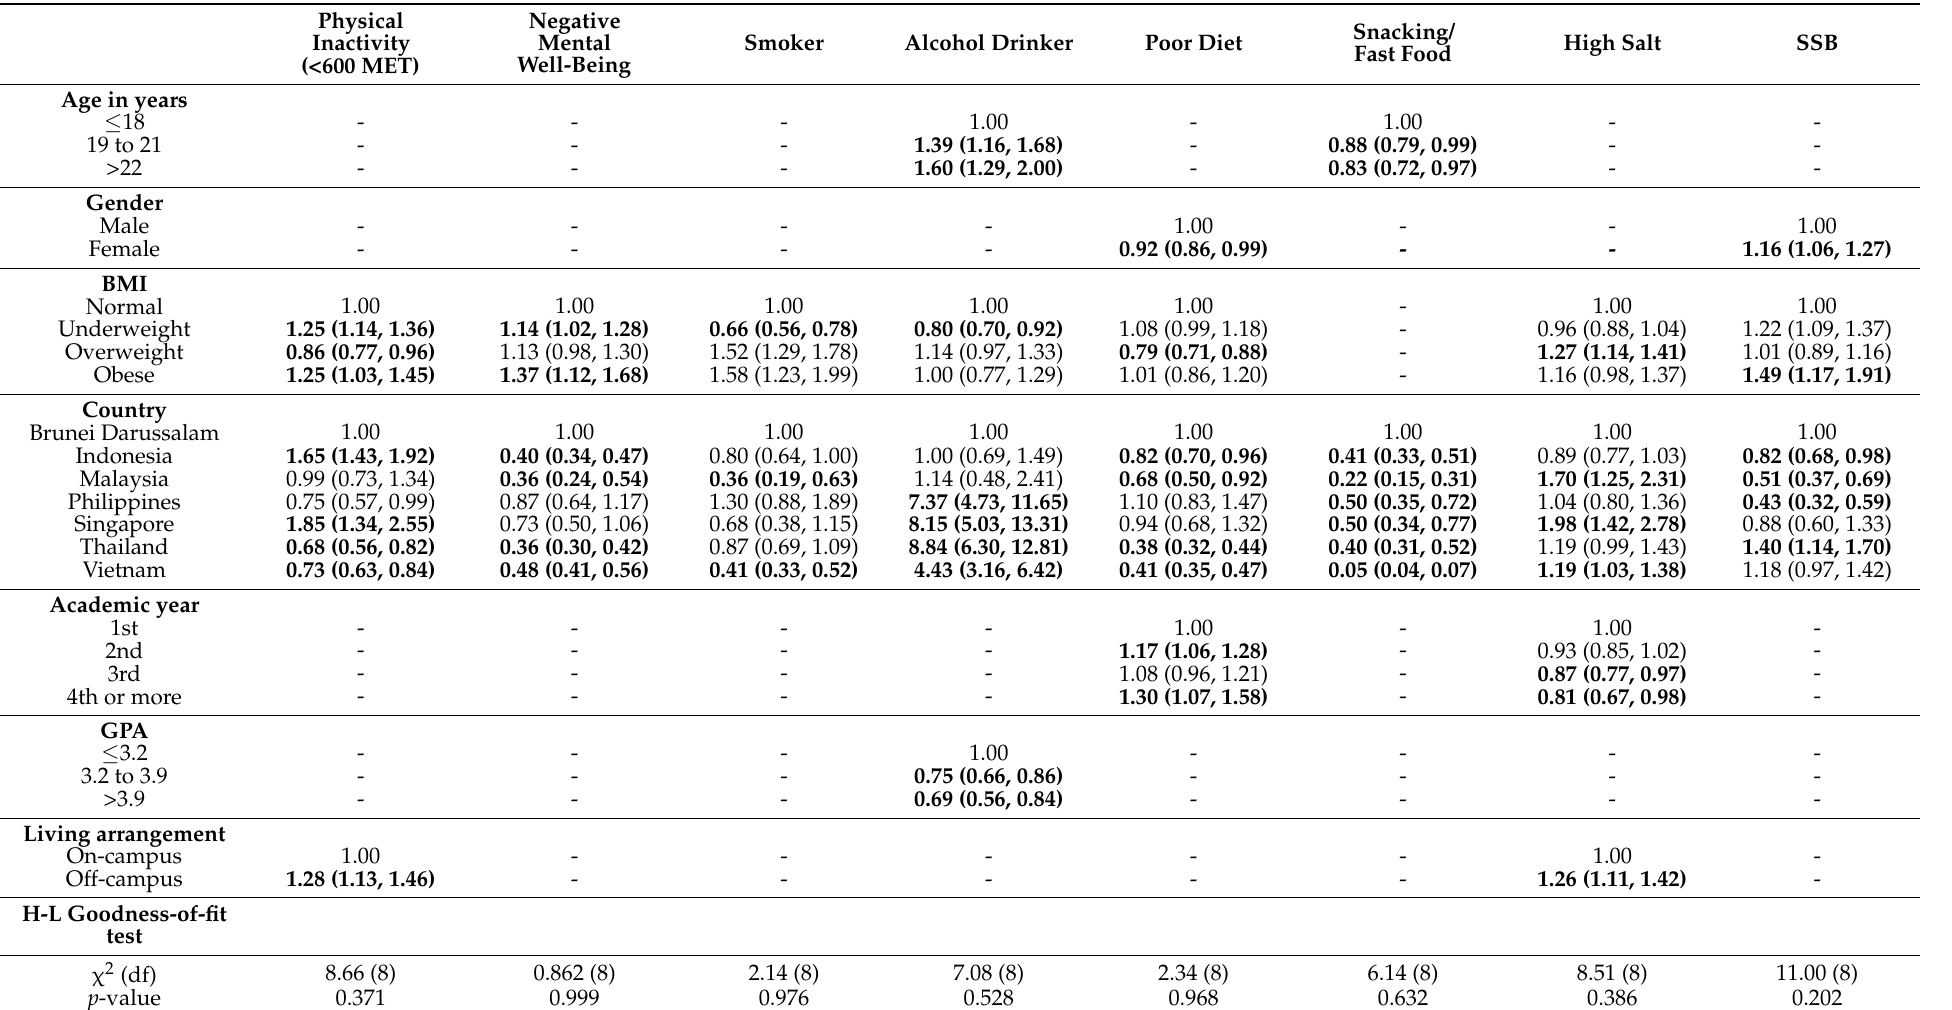
Table 5. Factors associated with health-risk behaviors using stepwise multiple logistic regression ( n = 15,366) (Adjusted Odds Ratio (95%CI)). Physical